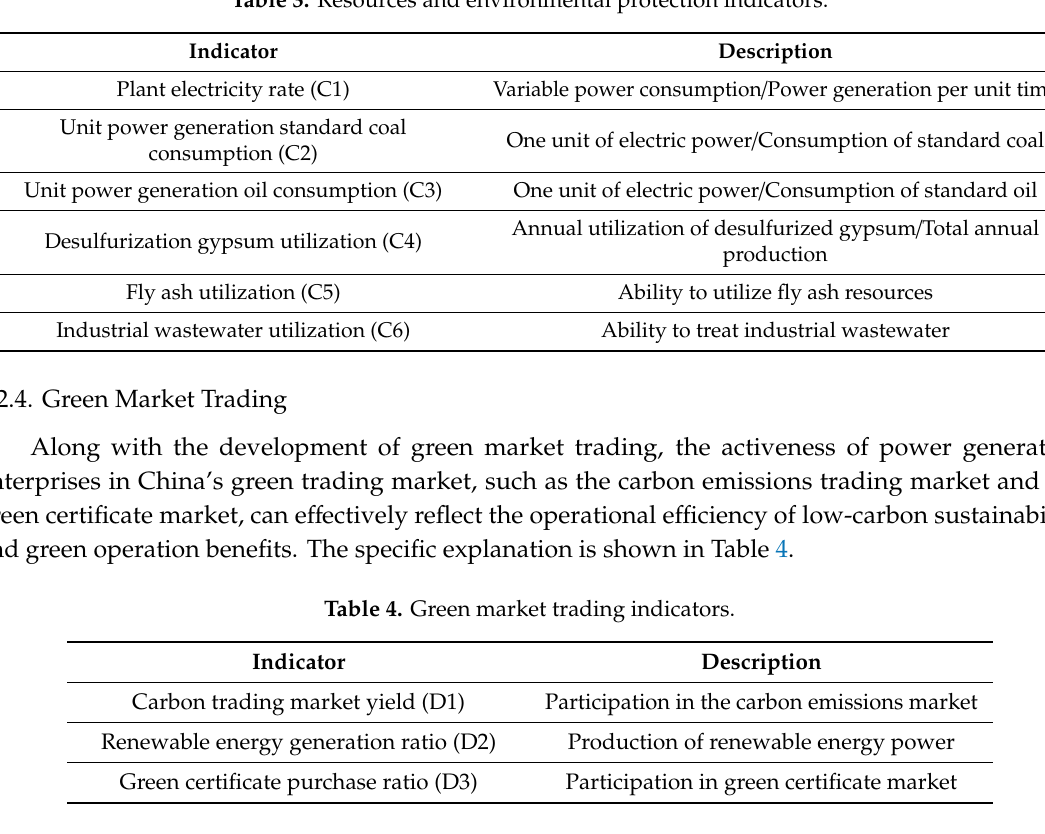
Table 3. Resources and environmental protection indicators.